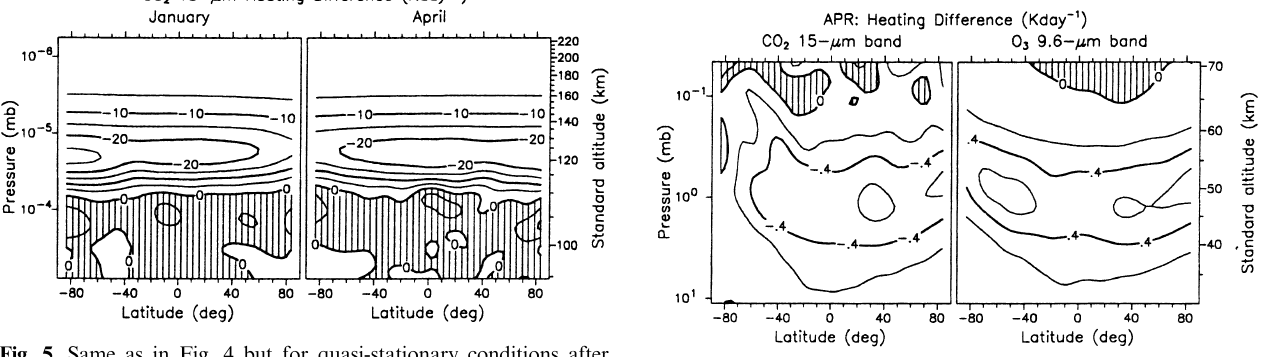
Fig. 7. Same as in Fig. 6 but